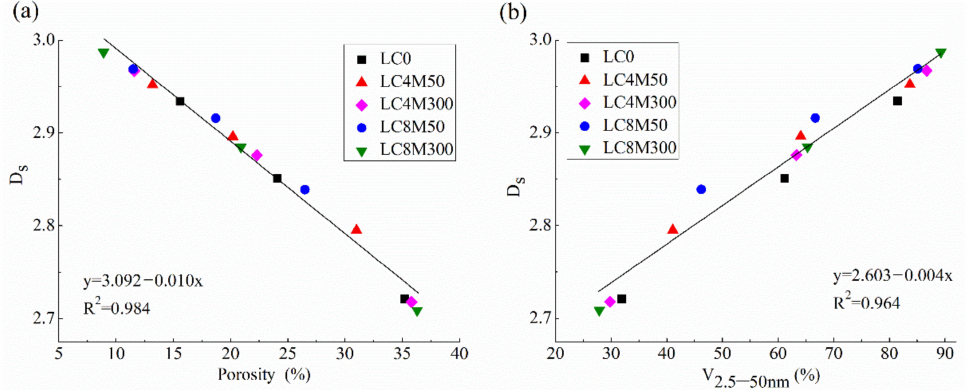
Figure 5. Relationship between D s and ( a ) porosity and ( b ) V 2.5–50 nm of